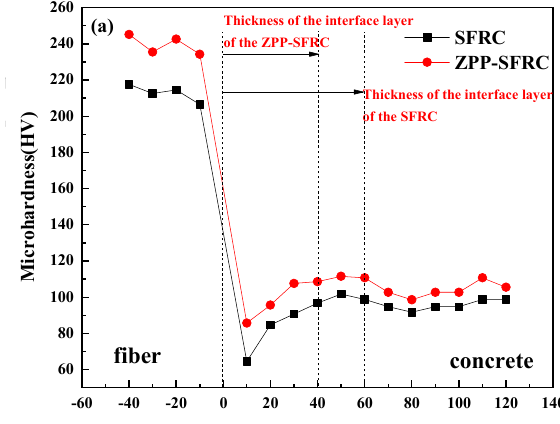
Figure 4. The comparison of the interface between steel fiber and concrete modified by zinc phosphate in a chloride corrosion environment and non-corrosion environment is shown in Figure 5.